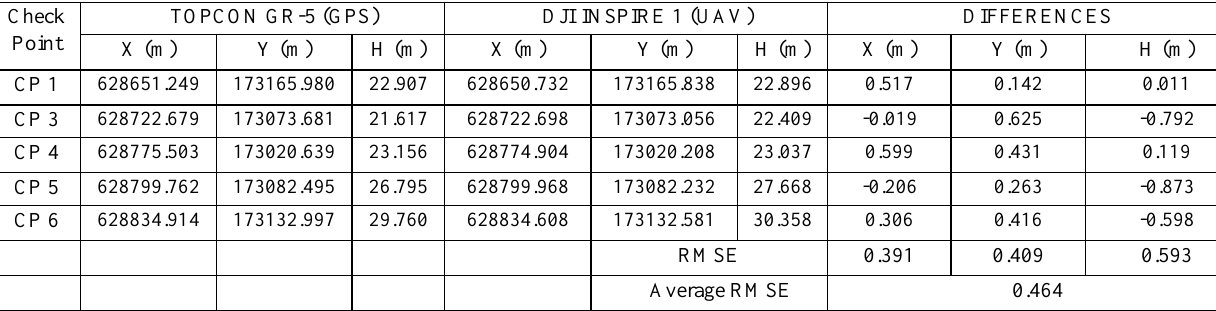
Table 4 . Accuracy Assessment for Check Points at 60m Altitude